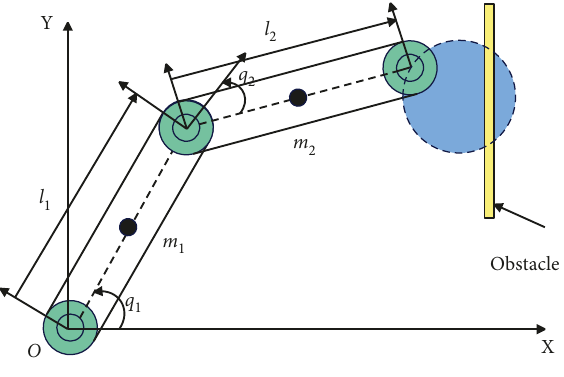
Figure 2: Plane two-joint robotic arm